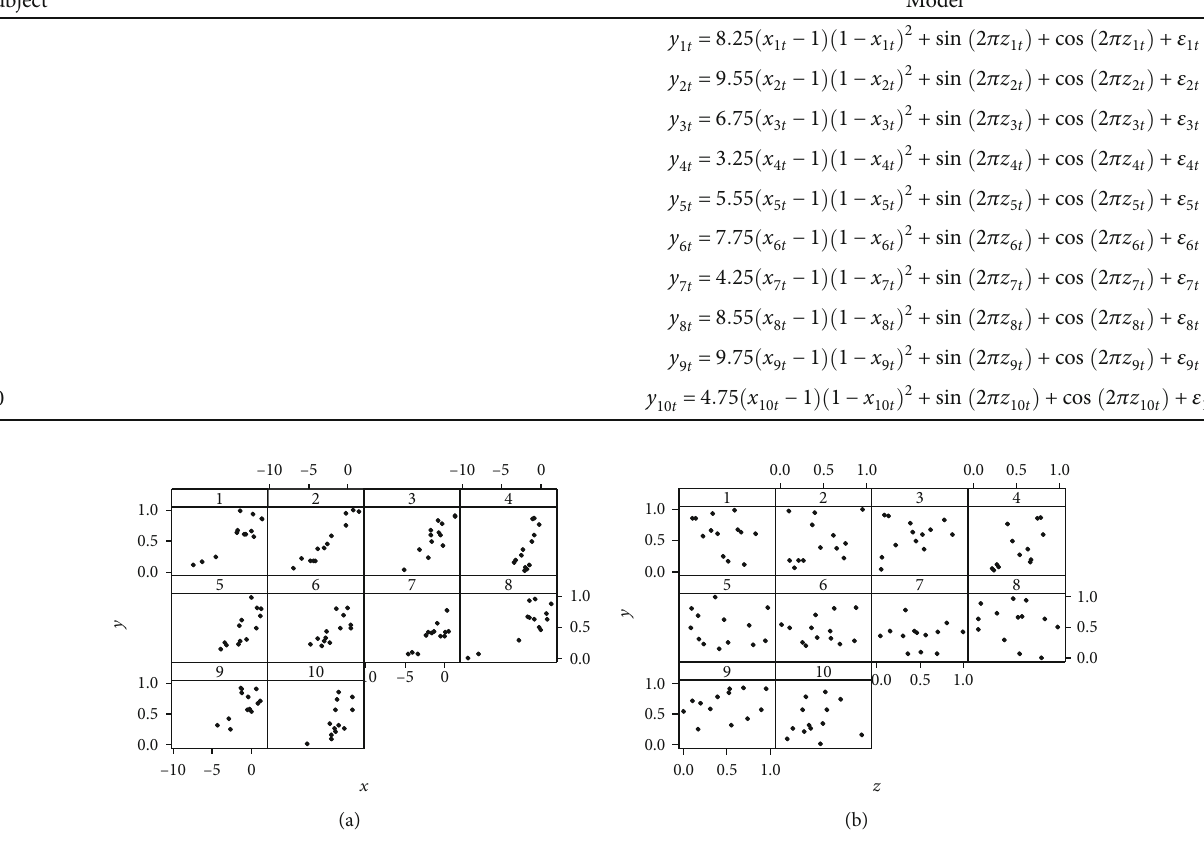
Figure 1: Scatterplot of simulated data for each subject and predictor: (a) truncated spline; (b) Fourier series. Table 2: Summary of simulation